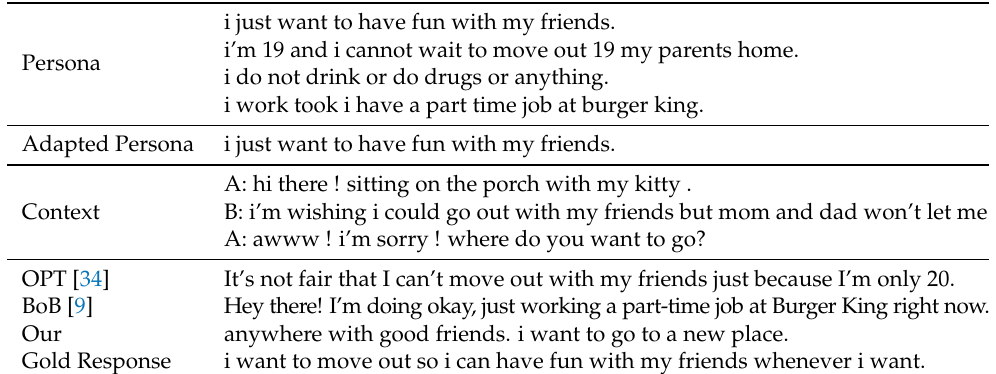
Table 8. A sample case generated by baselines and our model on